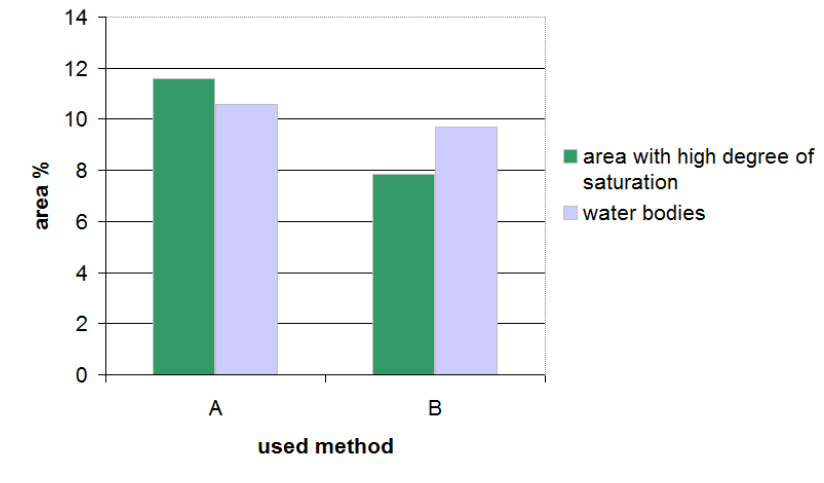
Figure 10. Impact of different classification methods on areal extent of derived classes. Method 1 (A): minimum/maximum of time series data; Method 2 (B): 5th percentile/95th percentile of time series